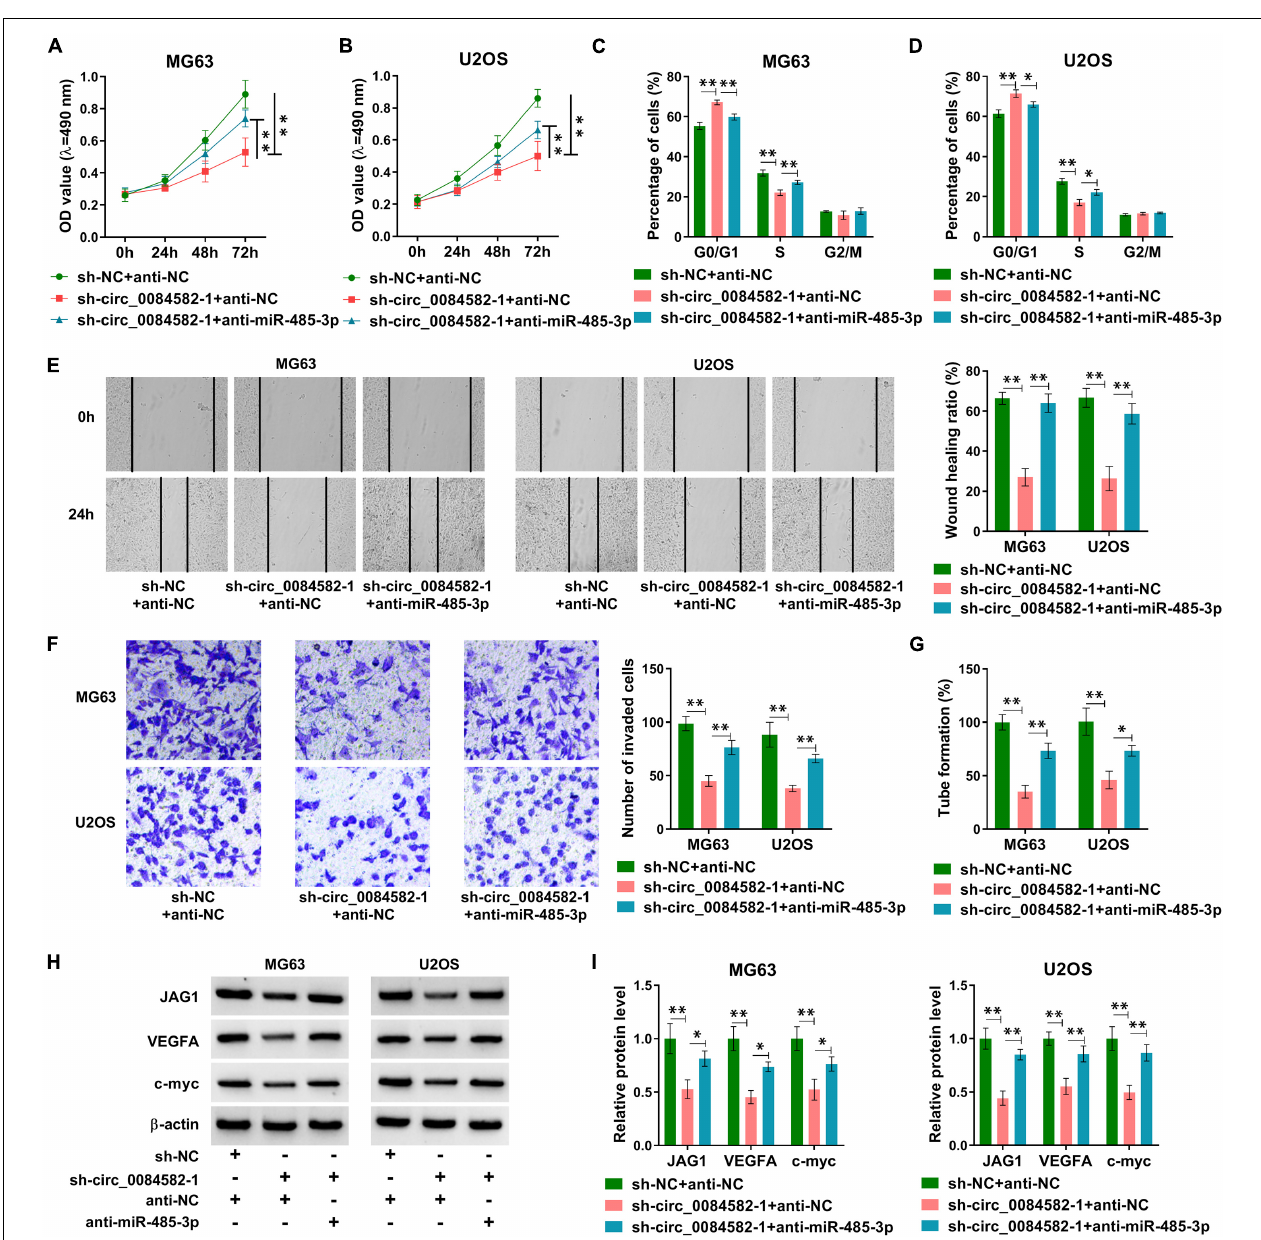
FIGURE 6 | The Circ_0084582/miR-485-3p axis regulates the malignant progression of OS. (A,B) The detection of cell viability was carried out by MTT assay in sh-NC + anti-NC, sh-circ_0084582-1 + anti-NC, or sh-circ_0084582-1 + anti-miR-485-3p transfection groups. (C,D) The analysis of cell cycle progression was performed by flow cytometry. (E,F) The examination of cell migration (E) and invasion (F) was conducted by wound-healing and transwell assays. (G) The tube formation assay was applied for the measurement of angiopoiesis. (H,I) Western blot was used for the protein determination of JAG1, VEGFA, and c-myc. All experiments were performed with three biological replications. ∗ P < 0.05, ∗∗ P <